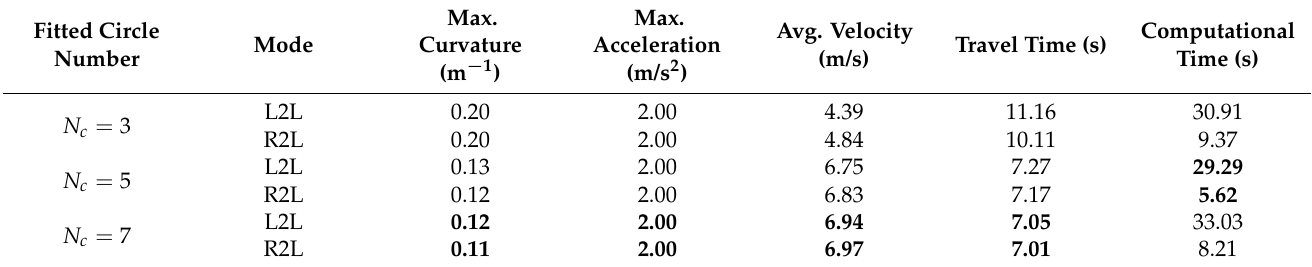
Table 4. The result of sensitivity analysis.